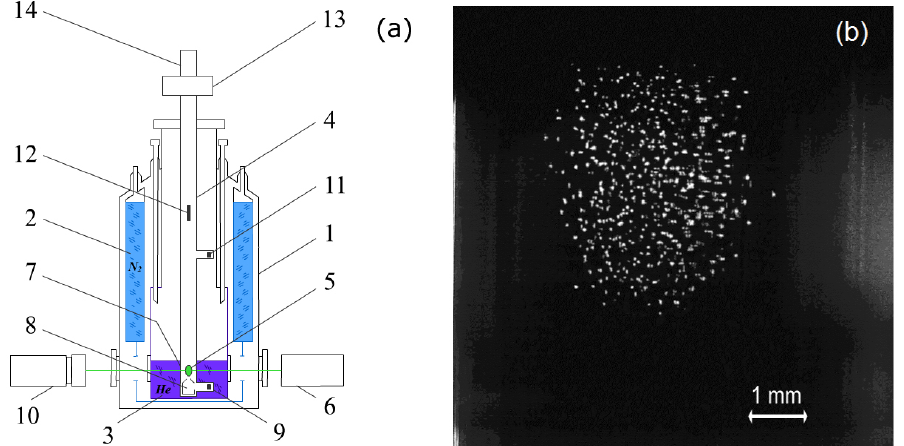
Figure 1. ( a ) Scheme of the experimental setup: 1—cryostat; 2—liquid nitrogen bath; 3—liquid helium bath; 4—gas discharge tube; 5—dusty plasma structure; 6—laser; 7—thermometer on the wall of the discharge tube; 8—dielectric cone; 9—cathode; 10—video camera; 11—anode; 12—dust particle injector; 13—cross-shaped connector; 14—pressure sensor; ( b )initial dust cloud. The pressure was measured using a Granville-Phillips 275 convectron, while the